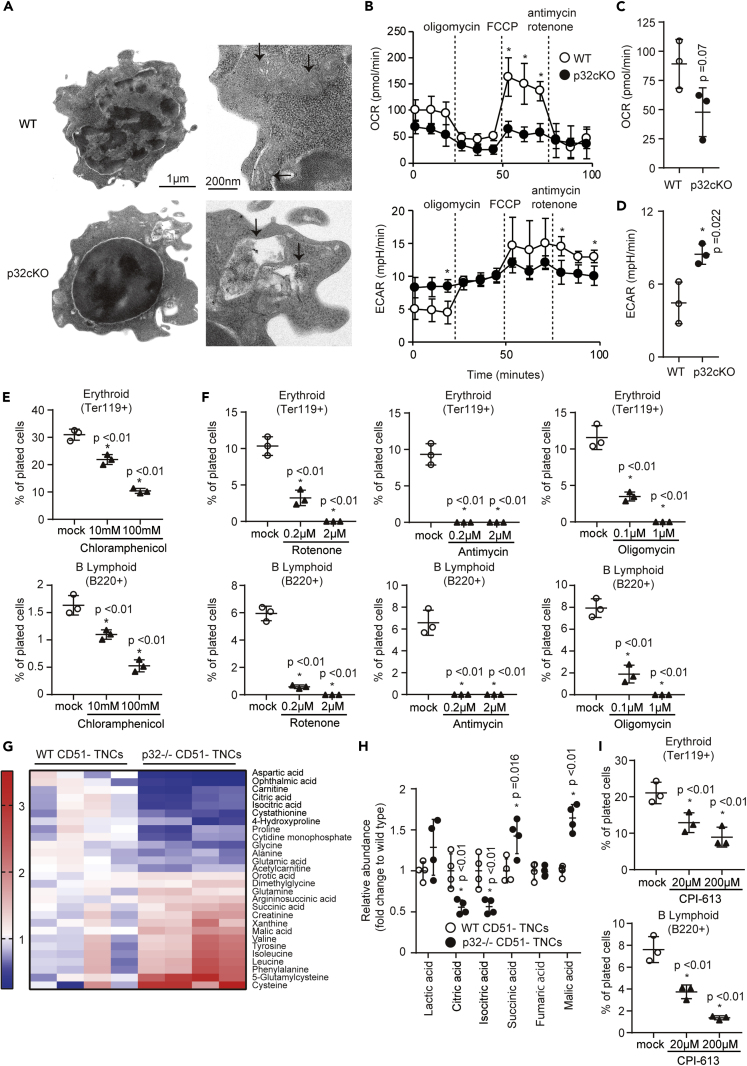
p32/C1qbp Regulates Mitochondrial OXPHOS in CD51– TNCs(A) Electron microscopic images of sorted CD51– TNCs. Images on the right highlight individual mitochondria (black arrows).(B–D) Measurements of the OCR and ECAR in CD51– TNCs (2×105 cells/well) from WT and p32cKO mice by an XF-24 extracellular flux analyzer. The real-time OCR and ECAR were determined during sequential treatments with oligomycin (ATP synthase inhibitor), FCCP, and antimycin-A/rotenone (ETC inhibitors) (B).(E, F, and I) Quantification of Ter119+ (erythroid) and B220+ (B-lymphoid) cells that were differentiated from sorted CD51– TNCs of WT mice seeded in liquid culture with cytokines in the presence or absence of chloramphenicol (E), rotenone, antimycin, oligomycin (F), and CPI-613 (I) for 48 hr. Cell numbers in each population were normalized as the percentage of total cells plated per well (% of cells plated).(G) Comparisons of the amounts of metabolites between WT and p32−/− CD51– TNCs. Heat map of metabolites extracted from WT and p32−/− CD51– TNCs showing statistically significant changes (P < 0.05).(H) Comparisons of the amounts of metabolites associated with TCA cycle between WT and p32−/− CD51– TNCs. In B–F, H, I, data are shown as means ± SD. ∗p < 0.05 versus WT mice or DMSO controls. Data are representative at least three (A-I) independent experiments.See also Figures S5.